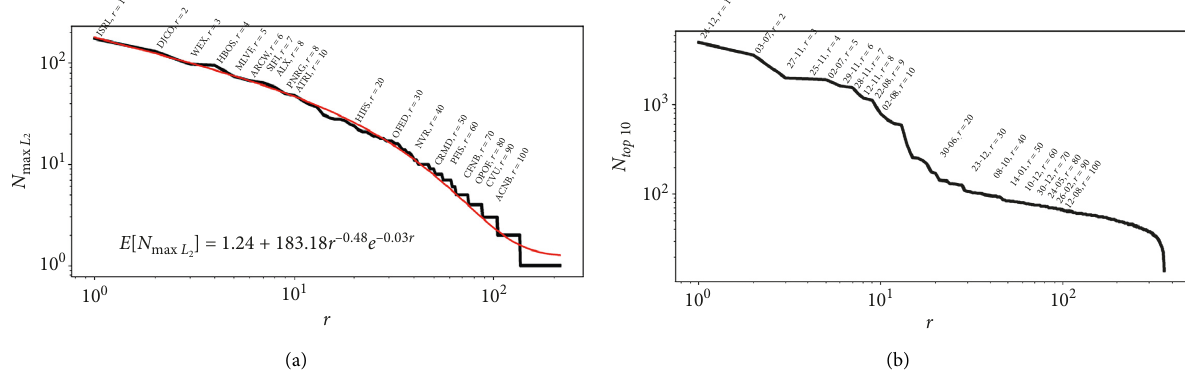
Figure 6: Though I displays quasi-stationary spectral behavior, it also displays significant heterogeneity across trading symbols, as shown 2 in (a) and regular seasonal spikes, as displayed in (b). For each trading symbol, we located the 10 days with the highest I in (b) Of the top 10 of these days, seven are directly adjacent to a incremented a counter associated with each, displayed as N top10